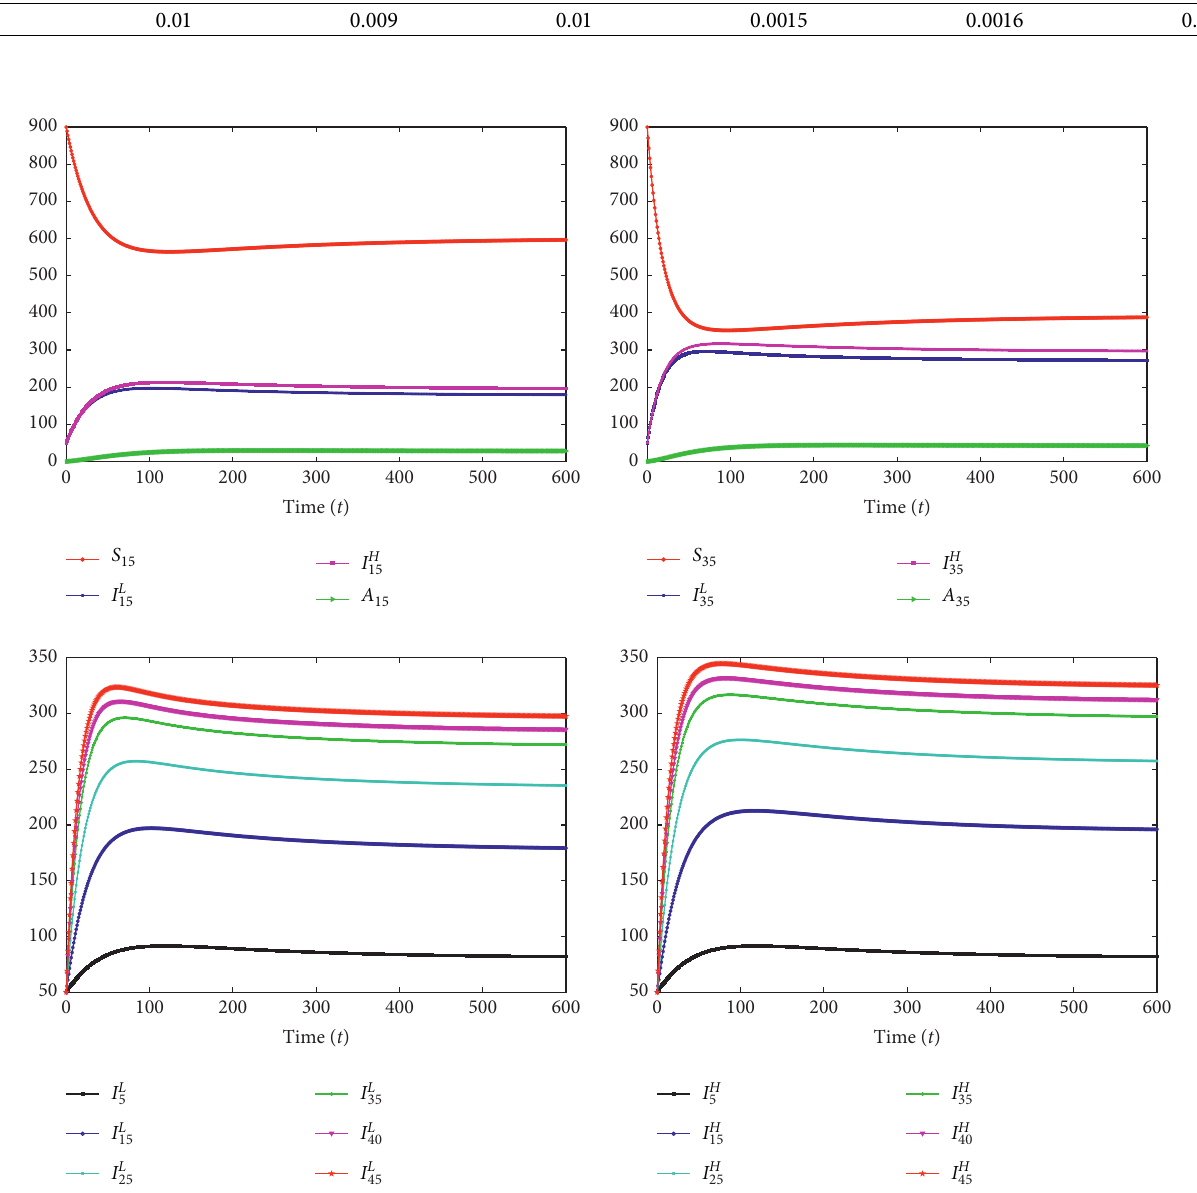
Figure 3: The time series and orbits of system (1) with R